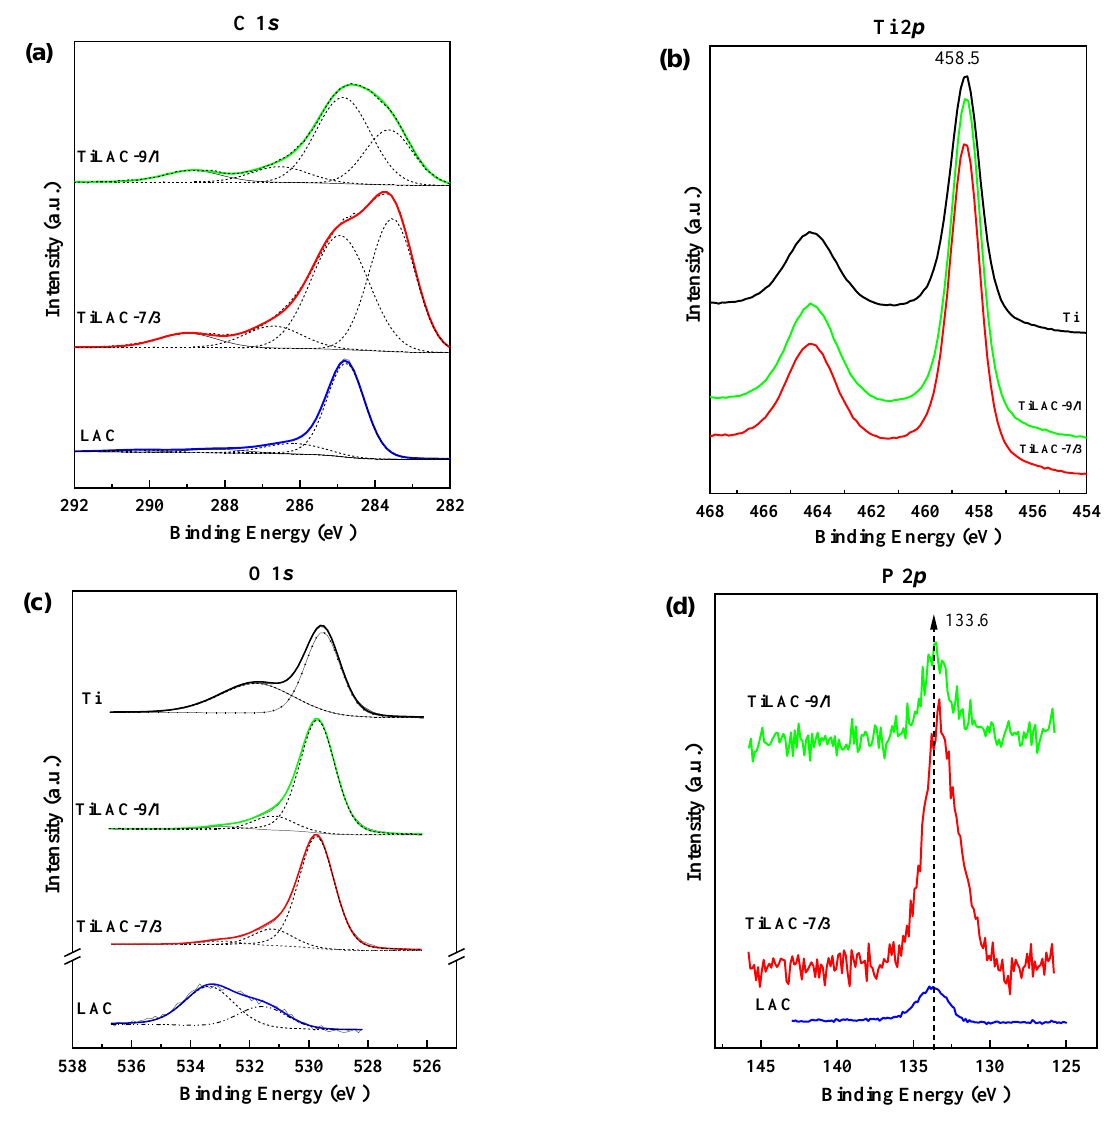
Figure 4. Core level spectra for all samples of ( a ) C 1 s , ( b ) Ti 2 p , ( c ) O 1 s and ( d ) P 2 p. Considering C 1 s signal, Ti and LAC samples show three contributions at ca. 284.8, 286.5, and 288.5 eV. The main contribution is located at 284.8 eV and assigned to C-C bonds in graphitic carbon and also from the adventitious carbon contamination layer. The other two contributions are due to alcoholic (C-O-H) and carbonyl C=O groups, respec- tively [41]. Moreover, the LAC sample shows another small contribution at 289.1 eV asso- ciated to ester (O-C=O) and CO 32- groups. In the case of samples containing both titania and LAC, a new contribution at ca. 283.7 eV appeared. This new contribution is due to the presence of two phases with dif- ferent conductivity, that is LAC and titania, and is also due to adventitious carbon. Ti 2 p core-level spectra for all samples presented two contributions associated with the doublet Ti 2 p 1/2 y Ti 2 p 3/2 , being the latter the most noticeable one at ca. 458.8 eV, which corroborates the presence of Ti 4+ octahedrally coordinated (see Figure 4b) [42]. Concerning the O 1 s core-level spectra (Figure 4c), differences between pure samples and composites become more evident. Table 2 includes the corresponding binding energy values. LAC signal presents a major contribution at 533.6 eV, which can be associated with organic C-O bonds in phenolic groups. In addition, a second contribution at lower binding energy, ca. 531.5 eV is present, attributable to carboxylate species. On the other hand, in the pure P25 sample, two signals are observed, one associated with oxygen in the lattice of TiO 2 (529.3 eV) and a second one at 532.1 eV, assigned to surface Ti-O-H groups. In the case of composites, signals associated to lattice oxygen in TiO 2 and LAC are present. Table 2. BE values corresponding to C 1s and O 1s signals (the relative contribution, in percentage, for the oxygen deconvoluted peaks appears in brackets). BE (eV) C 1 s Signal